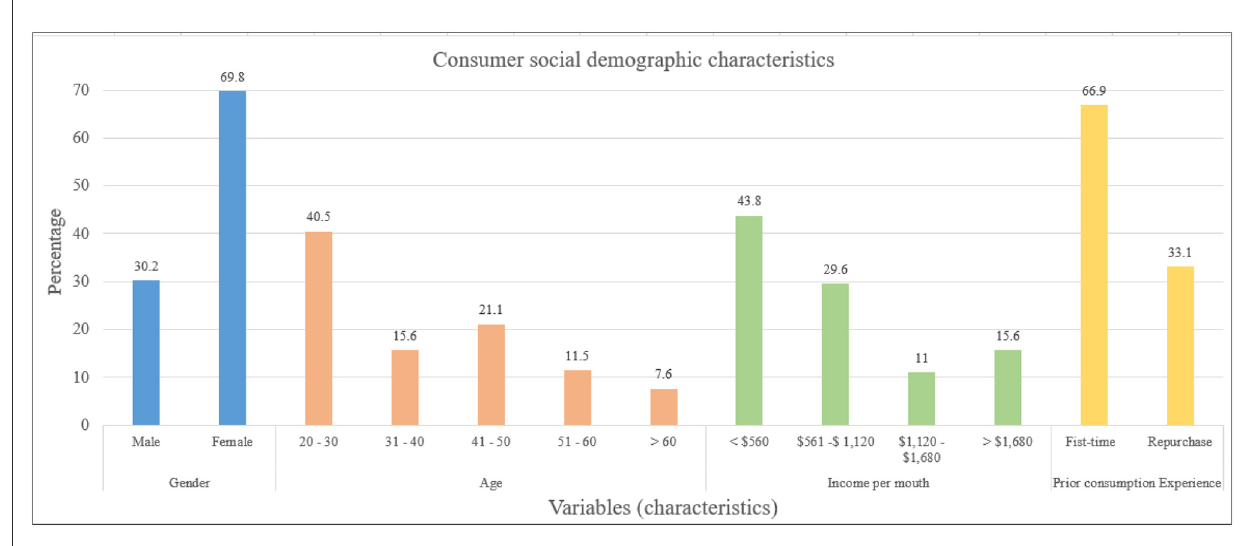
FIGURE1 Descriptive statistics of consumer social demographic characteristics ( n =